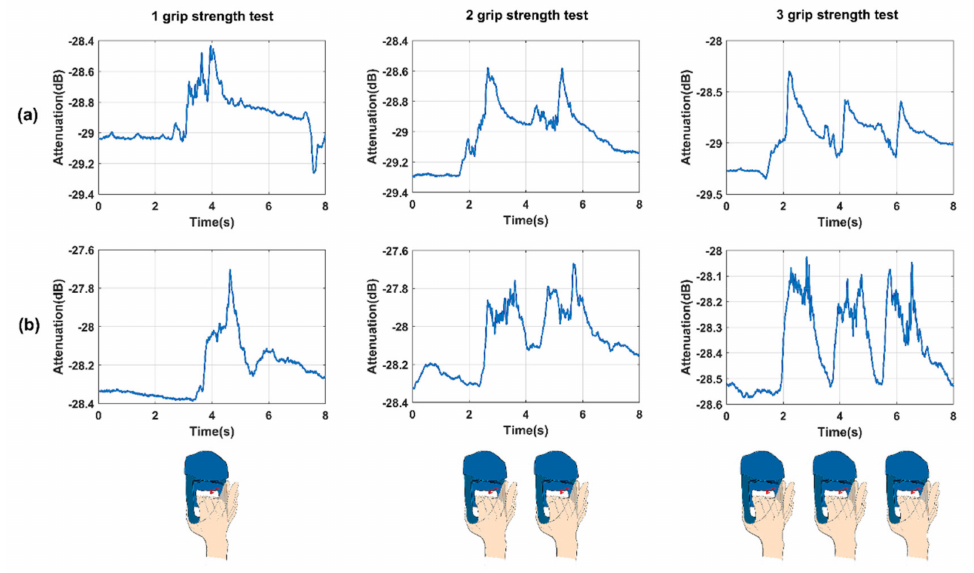
Figure 9. The dynamic body channel characteristics of the volunteers performing 1, 2, and 3 grip strength tests under ( a ) 550 kHz in linear distribution and ( b ) 510 kHz in quasi-logarithmic